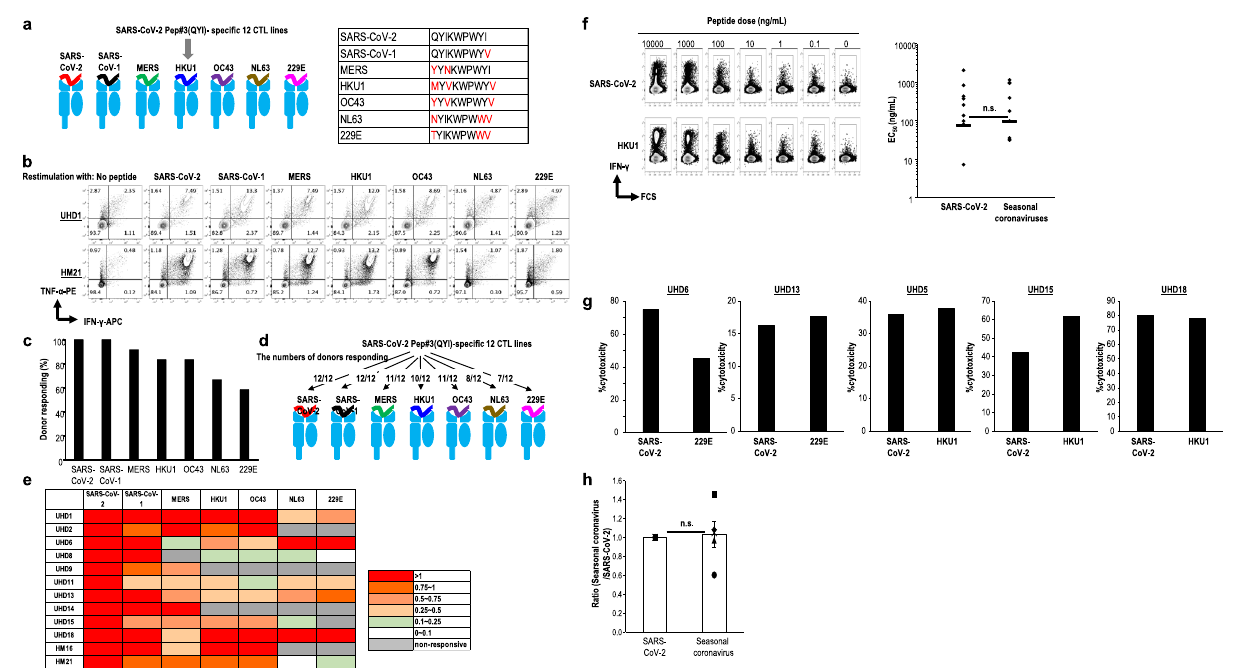
Fig. 6 Cross-reactivity of SARS-CoV-2 Pep#3(QYI)-speci fi c CD8 + T cells to other coronaviruses. a Cross-reactivity of SARS-CoV-2 Pep#3(QYI)-speci fi c CD8 + T cell lines from 12 UHDs and patients with HM to the relevant peptides of other coronaviruses (SARS-CoV-1, MERS, HKU1, OC43, NL63, and 229E). CD8 + T cell lines were restimulated with the indicated peptide or DMSO for 16h and analyzed using IFN- γ -APC and TNF- α -PE by ICS analysis. b Representative fl ow cytometry data from UHD1 and HM21 are shown. c Frequency of donors responding to each peptide of the coronaviruses. d The numbers of donors responding to each peptide of the coronaviruses. e The peptide-speci fi c CD8 + T cell frequency was calculated by subtracting the frequency of CD8 + T (pep − ) from that of CD8 + T(pep + ). The ratio of each coronavirus-derived peptide-speci fi c IFN- γ + TNF- α + CD8 + T cell frequency to that of CoV-2 pep#3 is depicted. ( n = 12). f Avidity of antigen-speci fi c CD8 + T cells. Flow cytometry data show IFN- γ expression for the indicated concentrations of peptides from SARS-CoV-2 and seasonal coronavirus (UHD1). Based on these data, half maximal response (EC 50 ) of Pep#3(QYI)-speci fi c CD8 + T cells was measured in the response to cognate peptide and the relevant peptide of seasonal coronaviruses. ( n = 9) (n.s., Mann – Whitney U -test). g , h Cross-functionality of Pep#3(QYI)-speci fi c CD8 + T cells. Peptide or -speci fi c cytotoxic activity of Pep#3(QYI)-speci fi c CD8 + T cells from 5 UHDs (UHD5, 6, 13, 15, and 18) was compared. Cytotoxic T cell assays were performed using Pep#3(QYI)-pulsed A24/CIR or the seasonal coronavirus derived peptide-pulsed A24/CIR as target cells (E/T ratio = 50). The cytotoxicity assay was performed in duplicates. Data represent the mean of duplicate ( g ). The white bar and other symbols represent the mean of values from